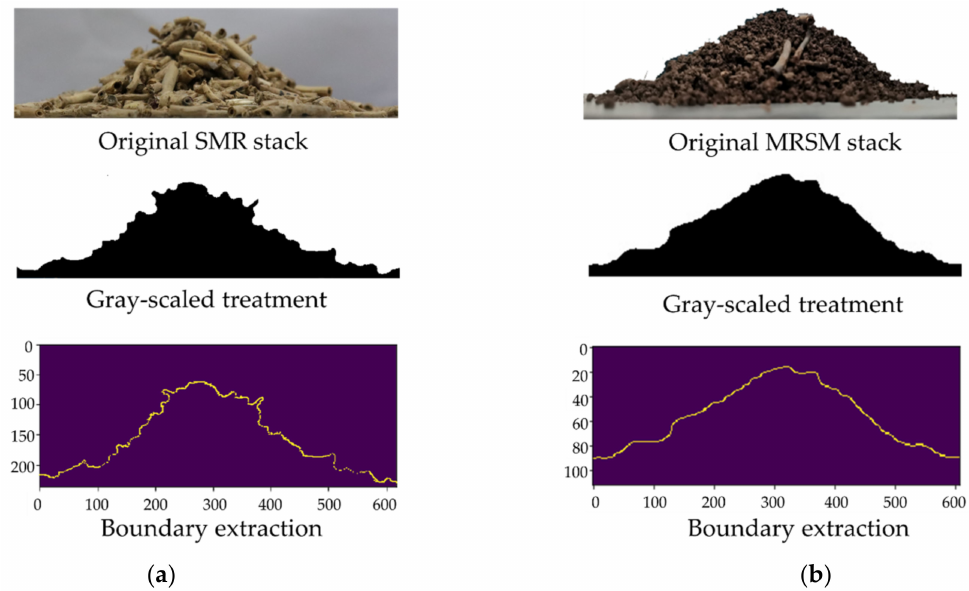
Figure 14. The contour extraction process of the stack of SMR ( a ), and MRSM ( b